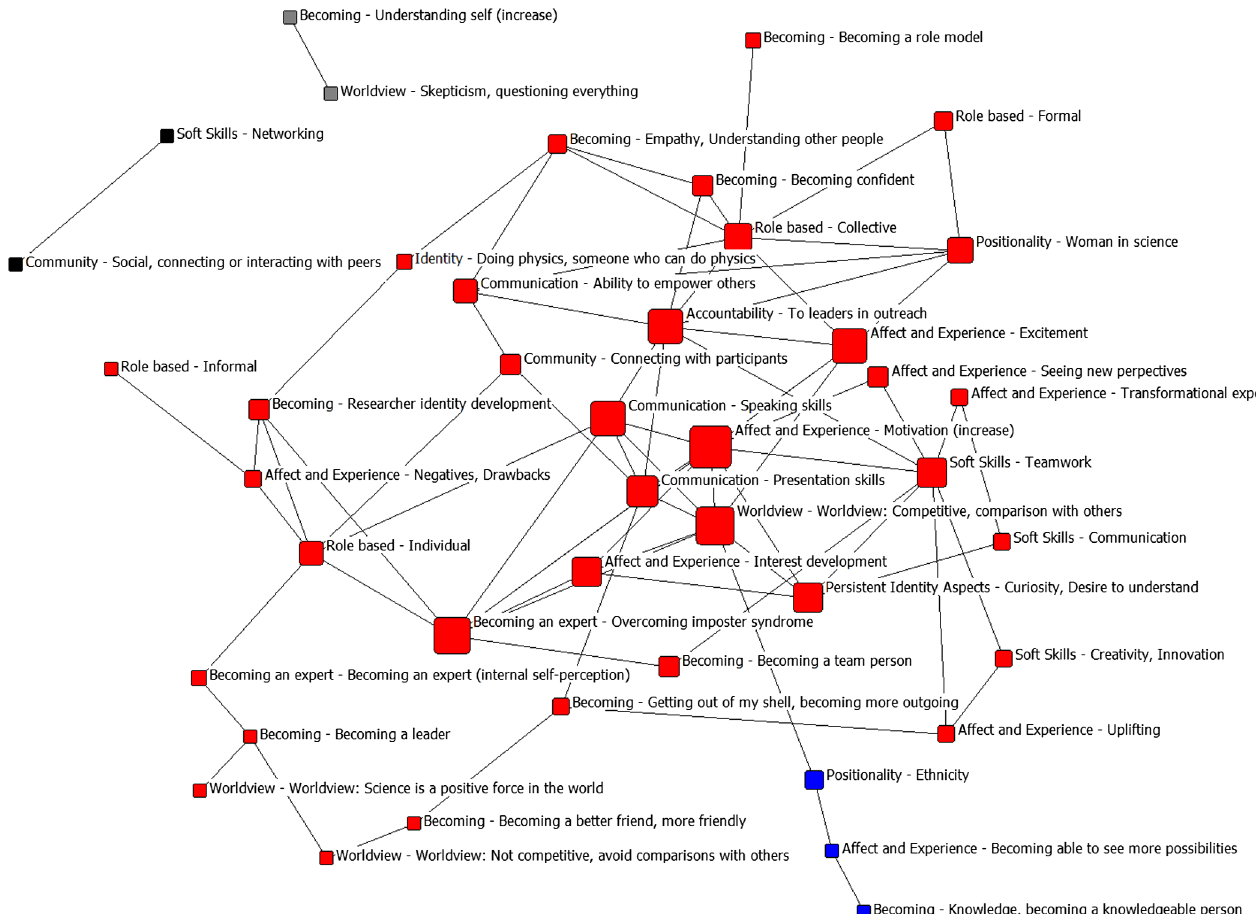
FIG. 6. Semantic network map comprising all codes from 35 interviews at the level of p < 0 . 01 . Note that the colors in the figure represent distinct clusters of statistically interconnected ideas but have no other